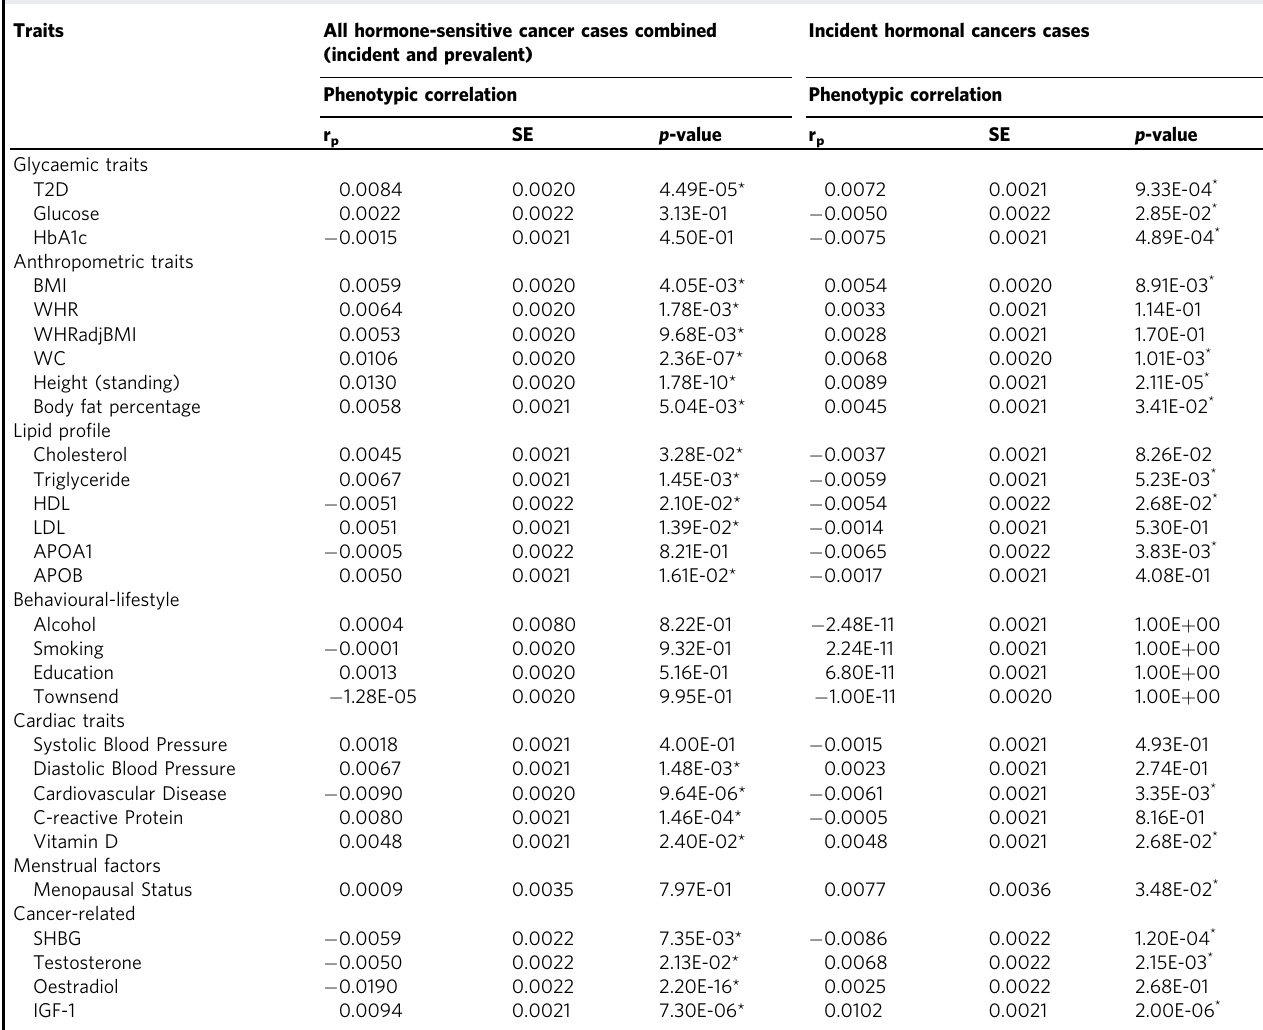
Table 3 Phenotypic correlation between hormone-sensitive cancers and other non-cancer traits in the UKB. Traits All hormone-sensitive cancer cases combined (incident and